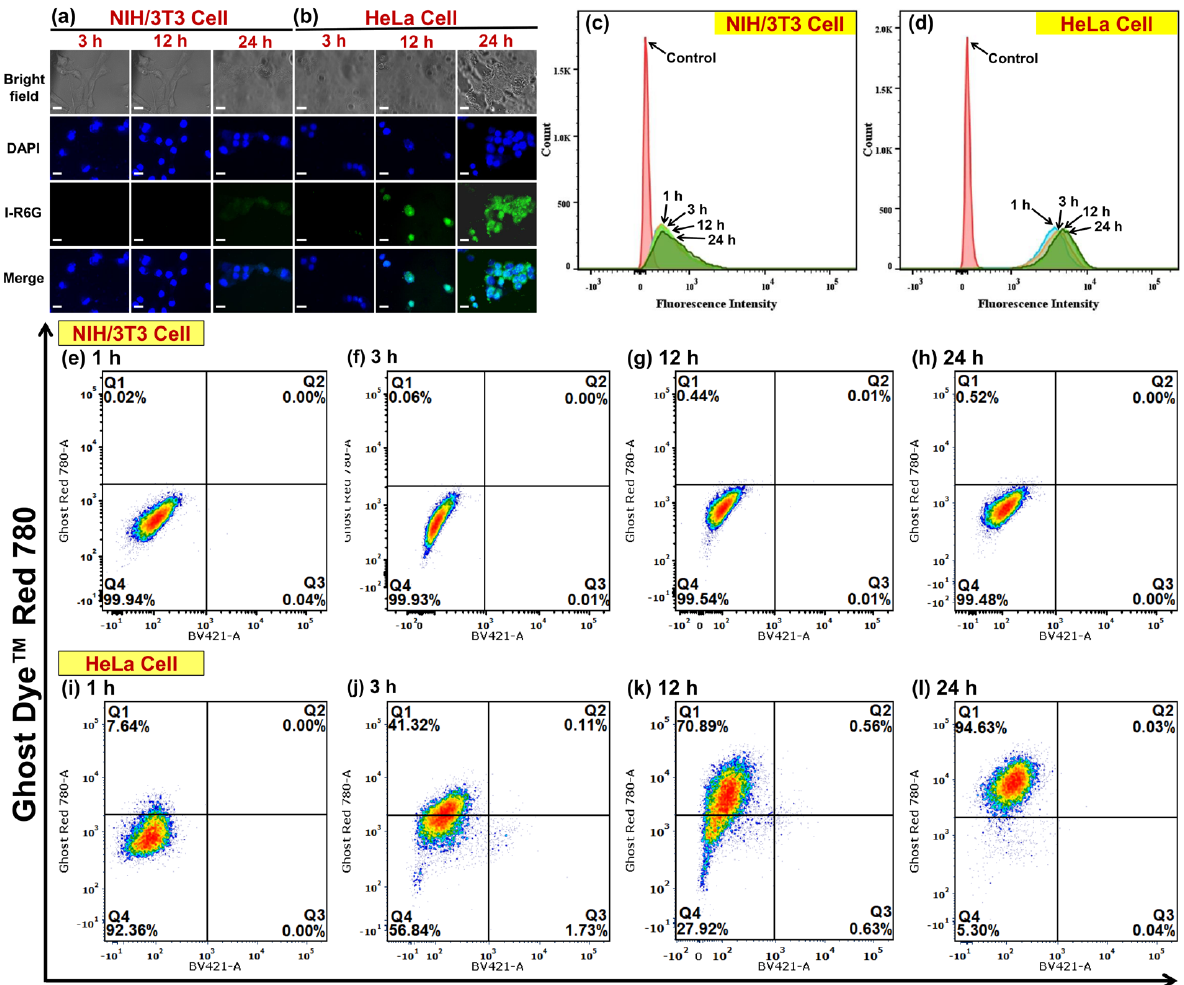
Figure 5. CLSM images of ( a ) NIH/3T3 and ( b ) HeLa cells cultured with CO 2 -treated I-R6G at 37 °C for 3, 12 or 24 h. The scale bar in each image represents 20 µ m. Flow cytometry histogram profiles of ( c ) NIH/3T3 and ( d ) HeLa cells cultured with CO 2 -treated I-R6G at 37 °C for 1, 3, 12 or 24 h. Representative flow cytometry dot plot diagrams of ( e – h ) NIH/3T3 and ( i – l ) HeLa cells incubated with CO 2 -treated I-R6G at 37 °C for 1, 3, 12 or 24 h, then double-stained with BV421 Annexin V and GDR-780.